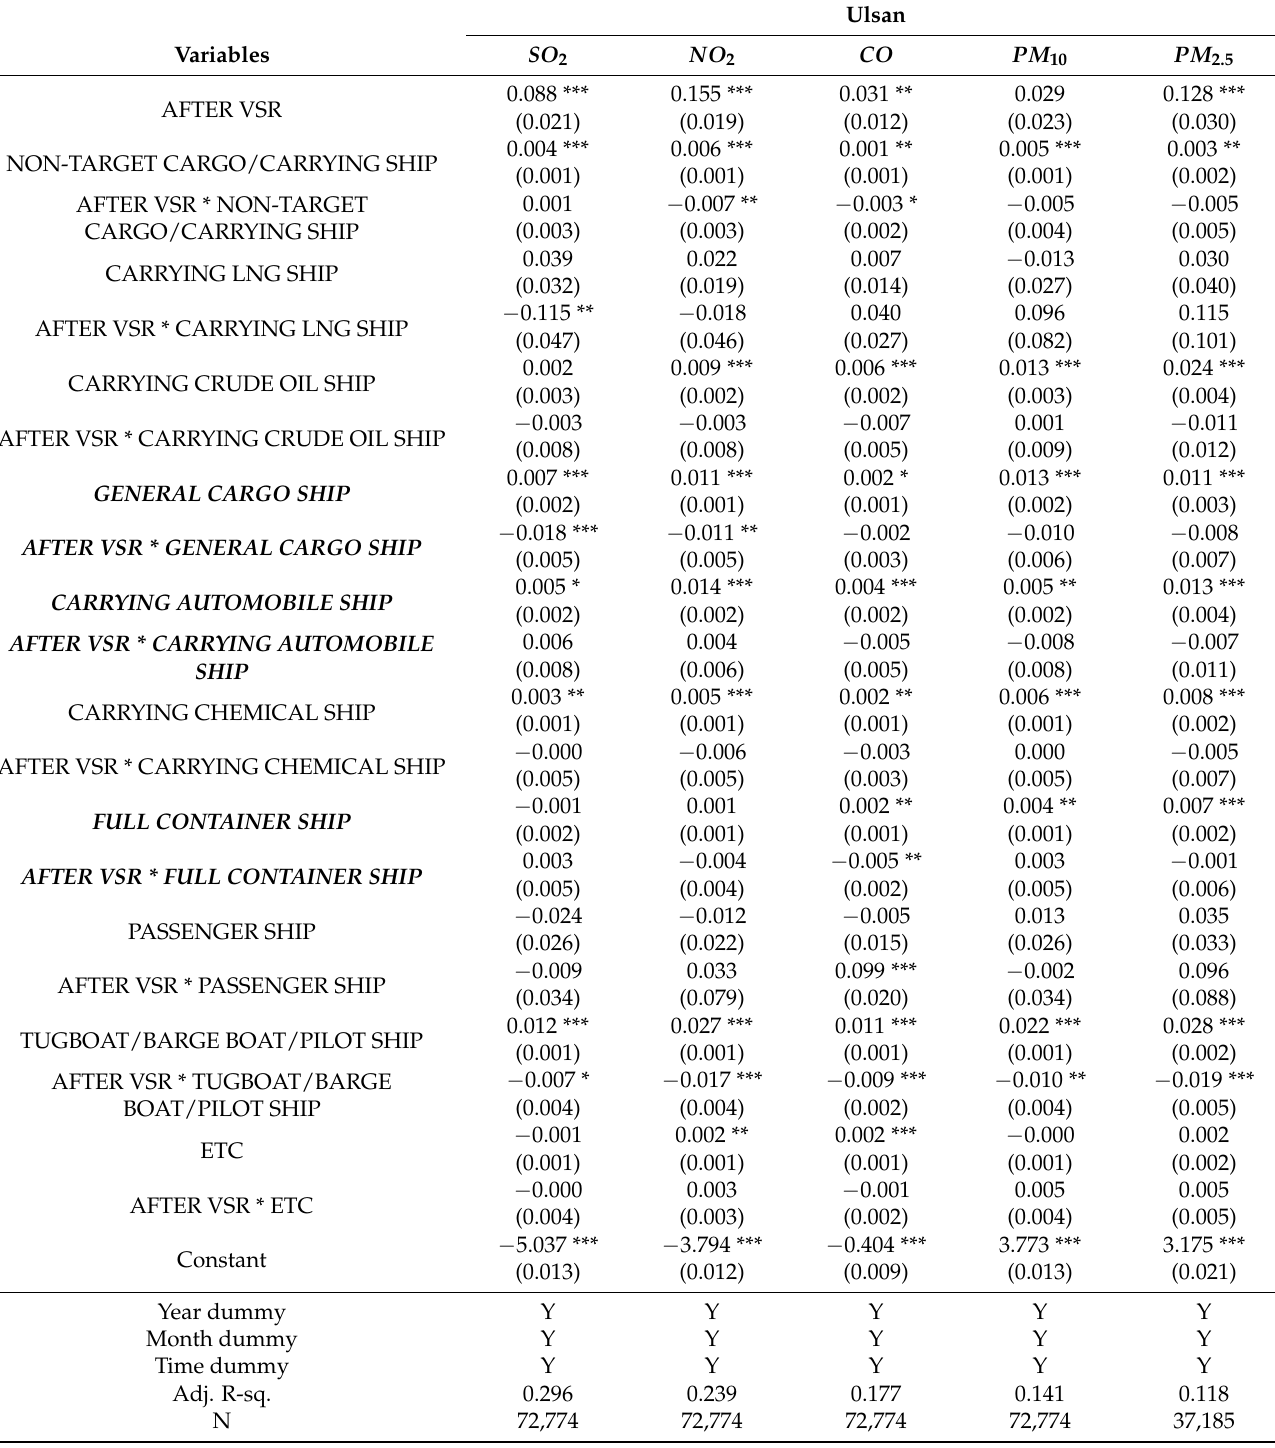
Table 5. Estimation results of Ulsan